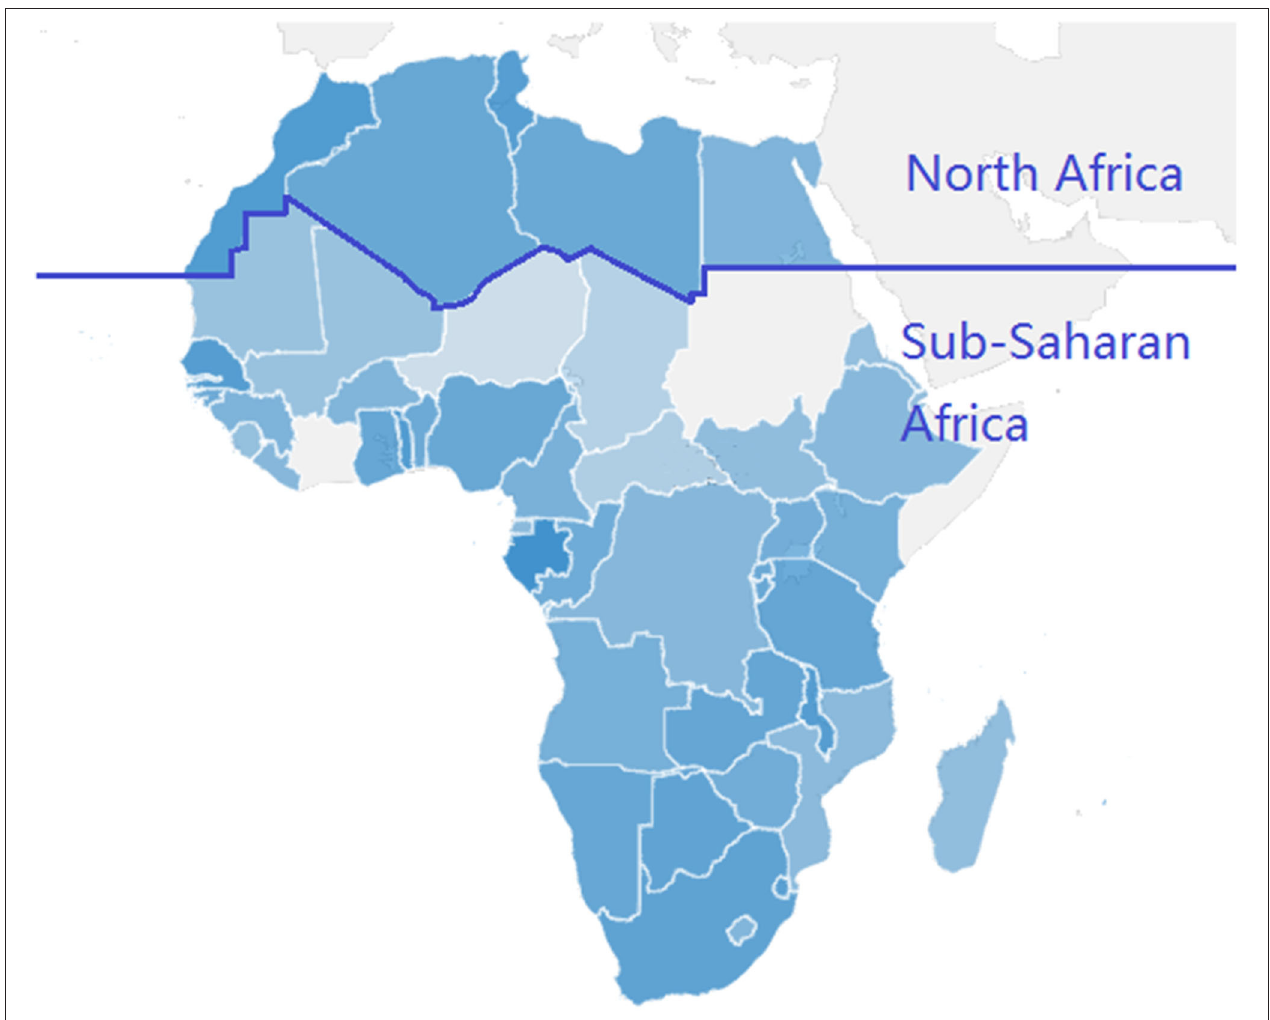
FIGURE 1 | Geographical distribution of SD score in Africa. (1) The darker the blue, the higher the SD score of the country, while gray indicates missing data. (2) Above the dark blue dividing line are North African countries, and below are Sub-Saharan African countries.